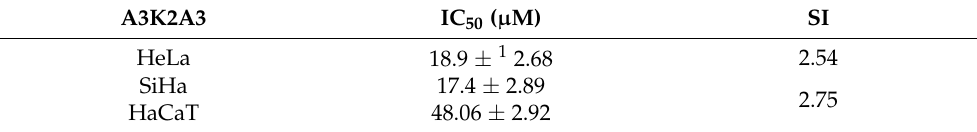
Figure 2. Cytotoxic activity in cervical cancer cells and HaCaT. Cells were treated with A3K2A3 (1–100 µ M) for 48 h, and cell viability was assessed using the MTT assay. Data represent the mean ± SD of three independent experiments that were performed in triplicate. HeLa; SiHa; HaCaT * p < 0.05 compared to 48 h NC of HeLa cells, + p < 0.05 compared to 48 h NC of SiHa cells, # p < 0.05 compared to 48 h negative control (NC) of HaCaT cells; (two-way ANOVA followed by Tukey’s post-test). Table 1. IC 50 of HeLa, SiHa, and HaCaT cell lines, and the SI after 48 h of